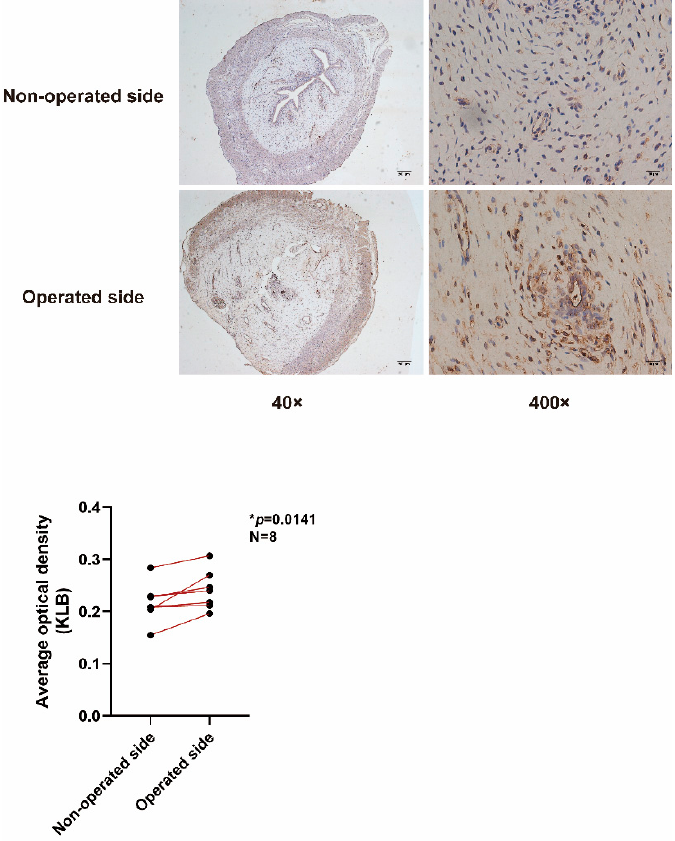
Figure 2. IHC to detect KLB in rats. The lumen surface of the uterus on the operative side (IUA side) was discontinuous, the uterine lumen was narrowed, and the glands of the damaged uterus were decreased. KLB was expressed in both epithelial and stromal cells of the rats, and KLB staining on the operative side was stronger than on the non-operative side. Statistical analysis of eight pairs of rat endometrial sections (400×) with ESCs showed significant differences ( p = 0.0141).